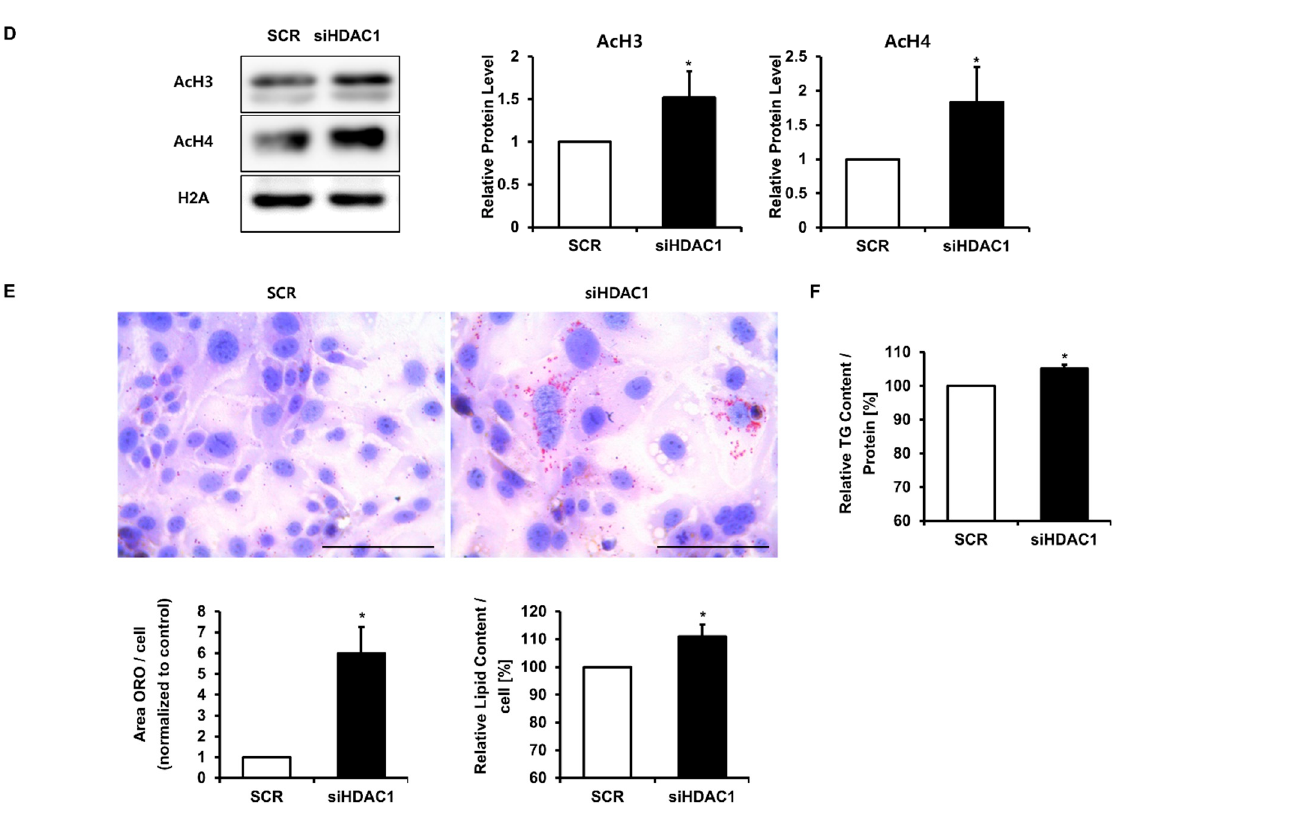
Figure 4. Histone deacetylase 1 (HDAC1) knockdown induced sterol regulatory element binding protein 1c (SREBP-1c) expression and lipogenesis in SZ95 cells. SZ95 cells were transfected with 100 nM negative control scrambled siRNA (SCR) or HDAC1 siRNA (siHDAC1) for 6 h and the medium was replaced with 10% FBS. After 48 h, ( A , B ) HDAC1 and SREBP-1c mRNA expression was measured using real-time PCR and ( C ) HDAC1 and SREBP1 protein expression was measured using Western blotting. α -Tubulin served as a loading control. ( D ) Histone H3 and H4 acetylation observed using Western blot analysis 48 h after HDAC1 knockdown. Histone H2A served as a loading control. ( E ) Lipid contents were visualized by Oil Red O staining, quantified using the Image J software (left), and eluted into isopropanol at 72 h. The optical density at 500 nm was determined using a microplate reader (right). Scale bar = 100 µm. ( F ) Triglyceride (TG) content analysis using a TG assay kit performed 72 h after HDAC1 knockdown. Data represent the mean ± SD of three independent experiments ( n = 3). * p < 0.05, ** p < 0.01, *** p < 0.001 vs. scramble siRNA-transfected control.